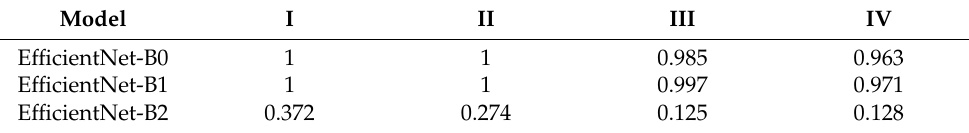
Table 3. Test results of secondary classification Index